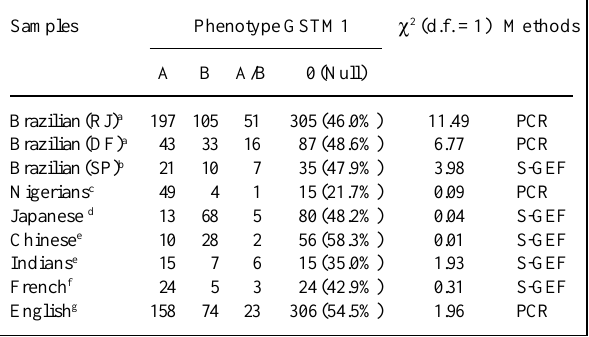
Table II - Distribution of glutathione S-transferase M1 phenotype frequencies in different populations. Samples